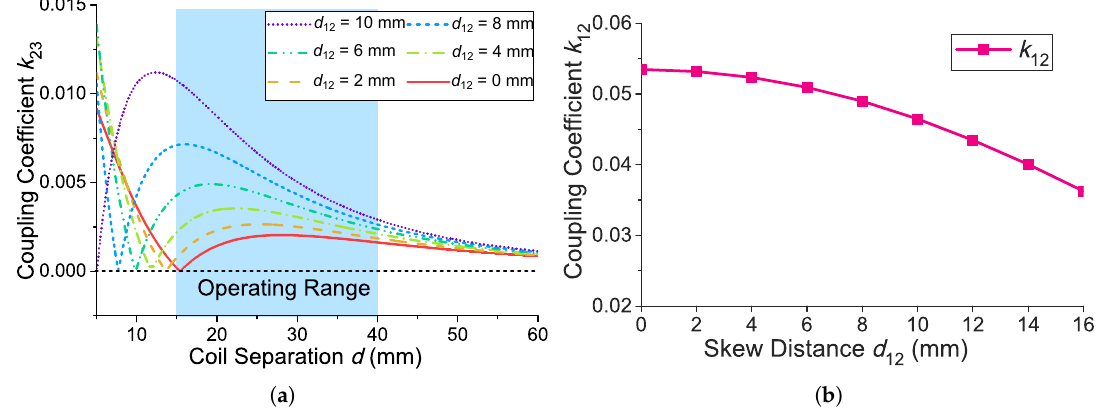
Figure 6. ( a ) Calculated coupling coefficient k 23 as a function of d versus different d 12 ; ( b ) calculated coupling coefficient k 12 versus different d 12 when the coil separation d is 20 mm.